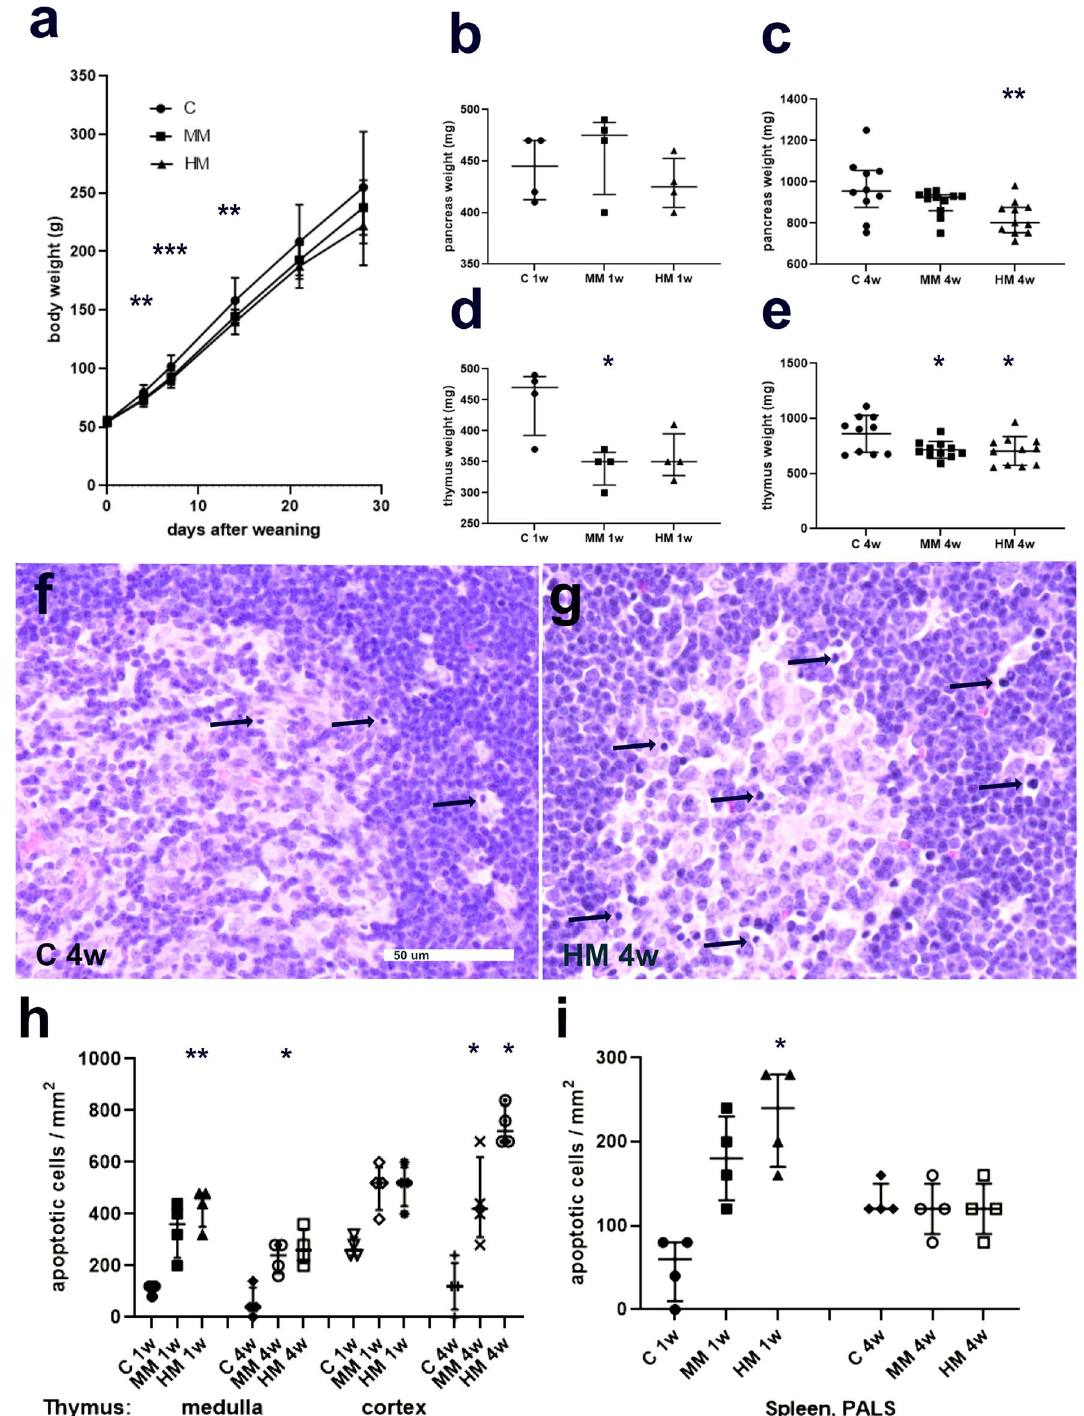
Figure 1. Body weights, thymus and pancreas weights and apoptosis in thymus and spleen in rats fed control (C), medium Maillard (MM)- and high Maillard (HM)-containing diets from weaning and start of experiment (day 0) to day 28. ( a ) Body weight (g) is presented as means ± SD, n = 14–14 (0–7 days) and 10–11 (14–28 days). ( b , c ) Pancreas and ( d , e ) thymus weights (mg) after 1 week (1w) and 4 weeks (4w). Data is in ( b – d ) presented as median (interquartile range) and in ( e ) as means ± SD; (b and d) n = 4, ( c , e ) n = 10–11. ( f , g ) Htx-E- stained sections of rat thymus after 4 weeks on ( f ) C diet (C 4w) or ( g ) HM diet (HM 4w). Increased number of pyknotic/ apoptotic lymphocytes (exemplified with arrows) is noted after the HM diet. Scale bar is 50 μm and applies to both ( f , g ). ( h , i ) Cell counting revealed increased numbers of apoptotic lymphocytes in both thymic medulla and cortex ( h ), as well as in periarteriol lymphoid sheats (PALS) in the spleen ( i ). Data presented as median (interquartile range), n = 4 for rats on diet for 1w and n = 10–11 for 4w. Comparisons between groups were done with Kruskal–Wallis followed by Dunn’s multiple comparison test or one- way ANOVA followed by Dunnett’s multiple comparison test; *p < 0.05, **p < 0.01, ***p <